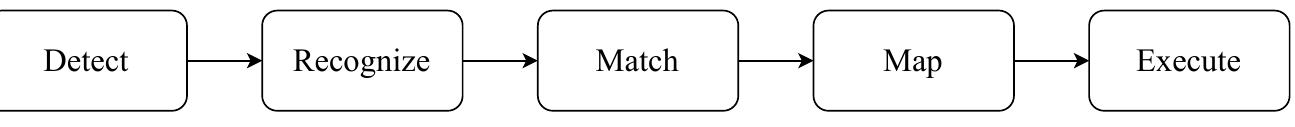
Figure 8. Simplified representation of the general idea behind the sequence matching algorithm. First, individual actions (gestures) are detected. They are stacked into a